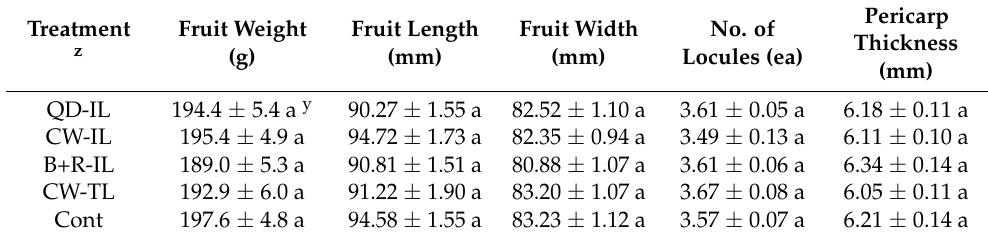
Table 3. Physical characteristics of fruits during the supplemental lighting ± SEM (n = 30).